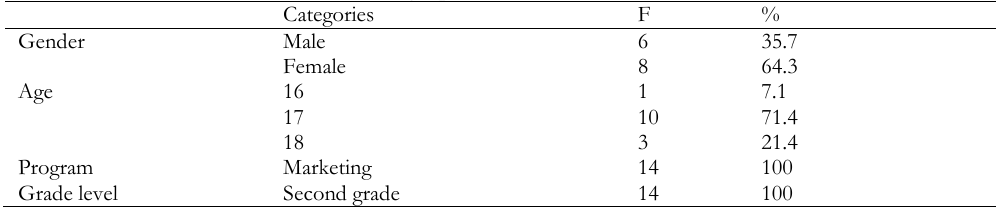
TABLE 1. Demographic characteristic of the